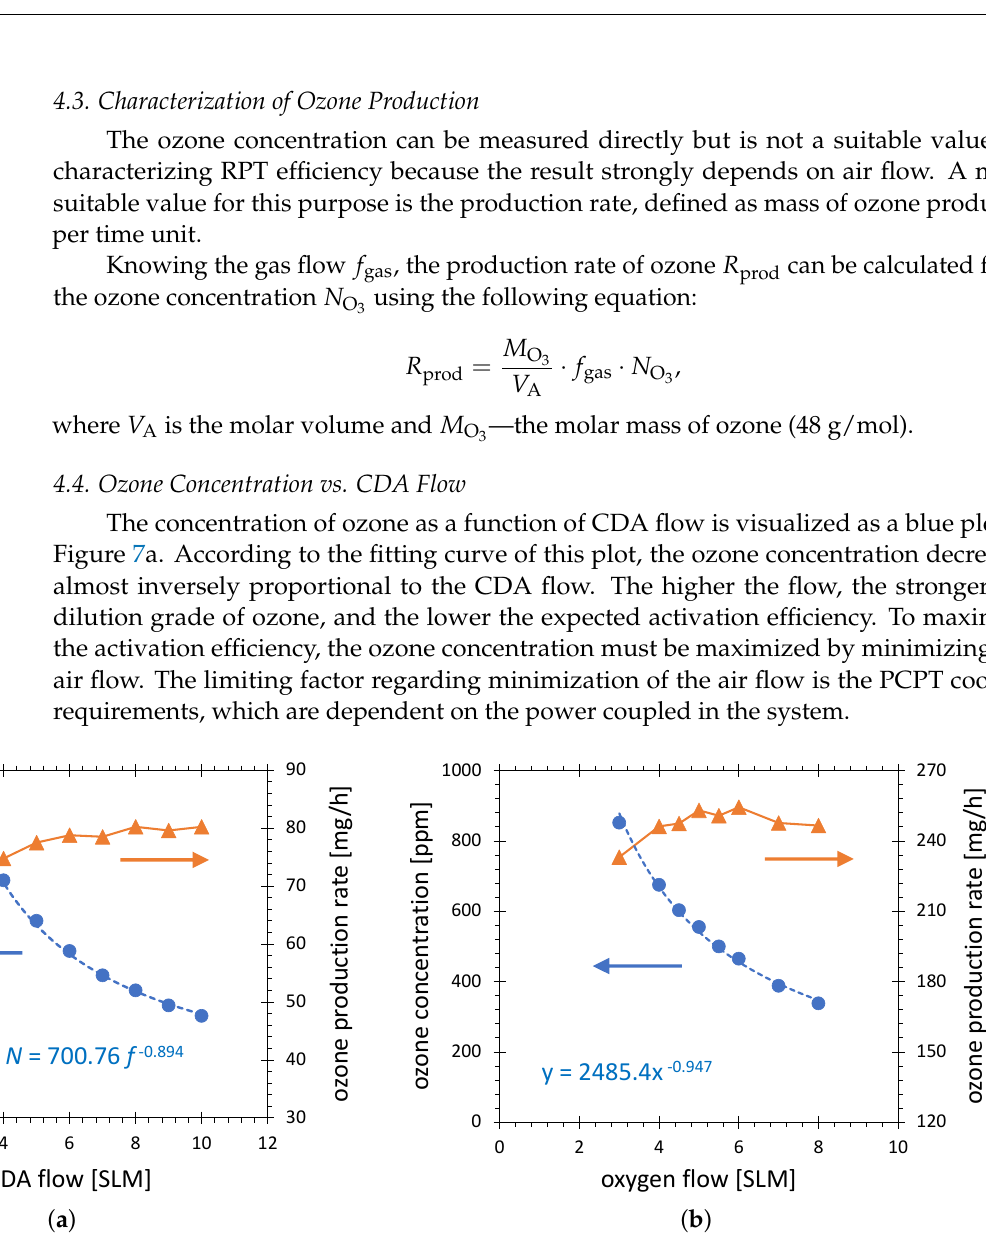
Figure 7. Concentration and production rate of ozone as a function of gas flow for ( a ) CDA (results from [11]) and ( b ) oxygen. The PCPG power is 8.3